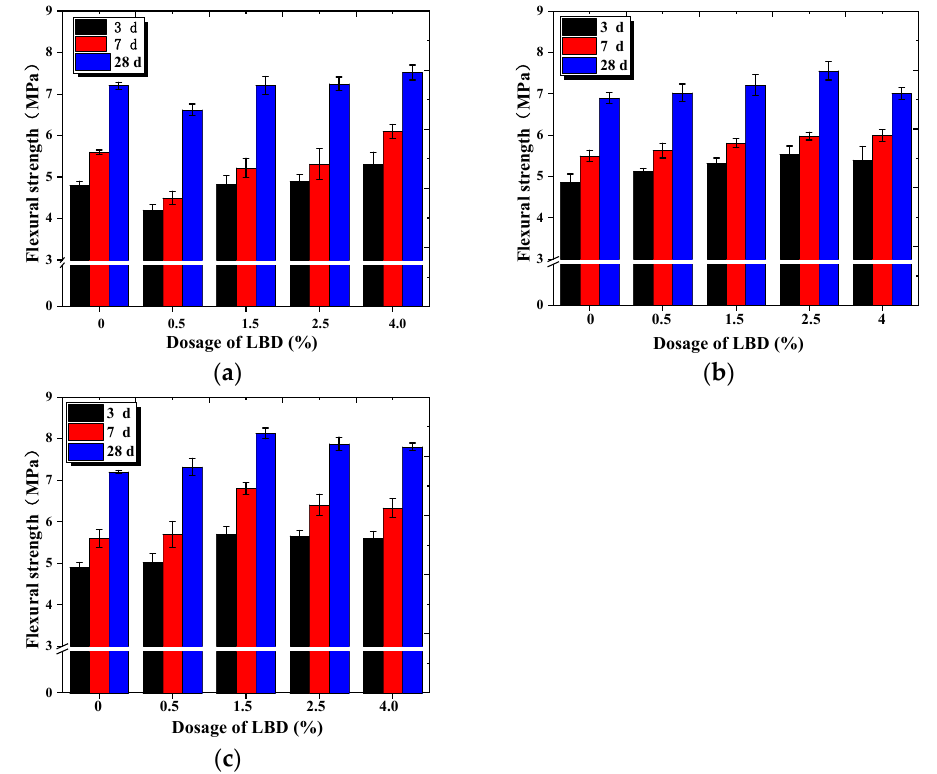
Figure 3. Flexural strength of LBD/OPC samples: ( a ) A-LBD/OPC samples; ( b ) B-LBD/OPC samples; ( c ) C-LBD/OPC samples.